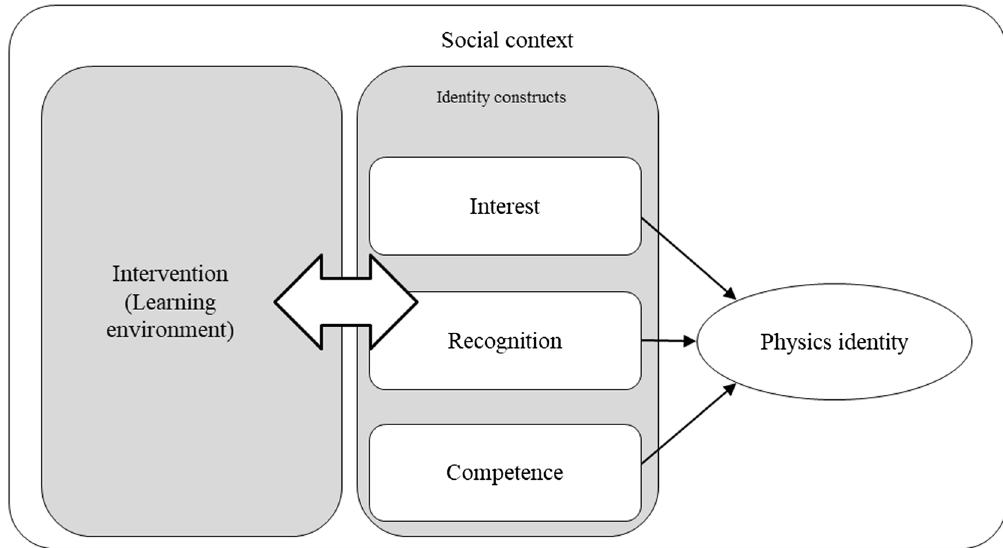
FIG. 1. Physics Identity Framework (adapted from Refs.